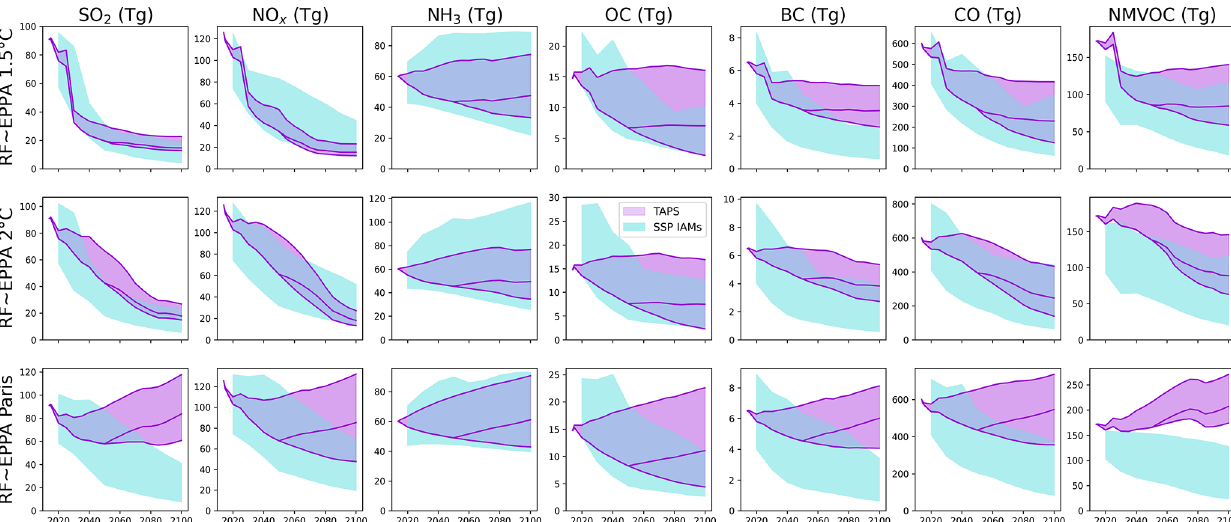
Figure 2. Global air pollutant emissions trends within the range of GAINS-based scenarios of current legislation (CLE Continued Trend) and maximum feasible reduction (MFR Mid-century; MFR Continued Trend) in Table 3 (top to bottom in purple), as compared to the range of SSP IAM corollaries in Table 2 (blue). The IAM estimates are subtracted by sectors not scaled by TAPS (aviation and open burning beyond agricultural waste), based on the proportion of their emissions in the best-fitting CMIP6 scenario (since sectoral IAM emissions are not available). Quantities of NO x are in Tg NO 2 ; quantities of BC, OC, and NMVOC are in TgC.